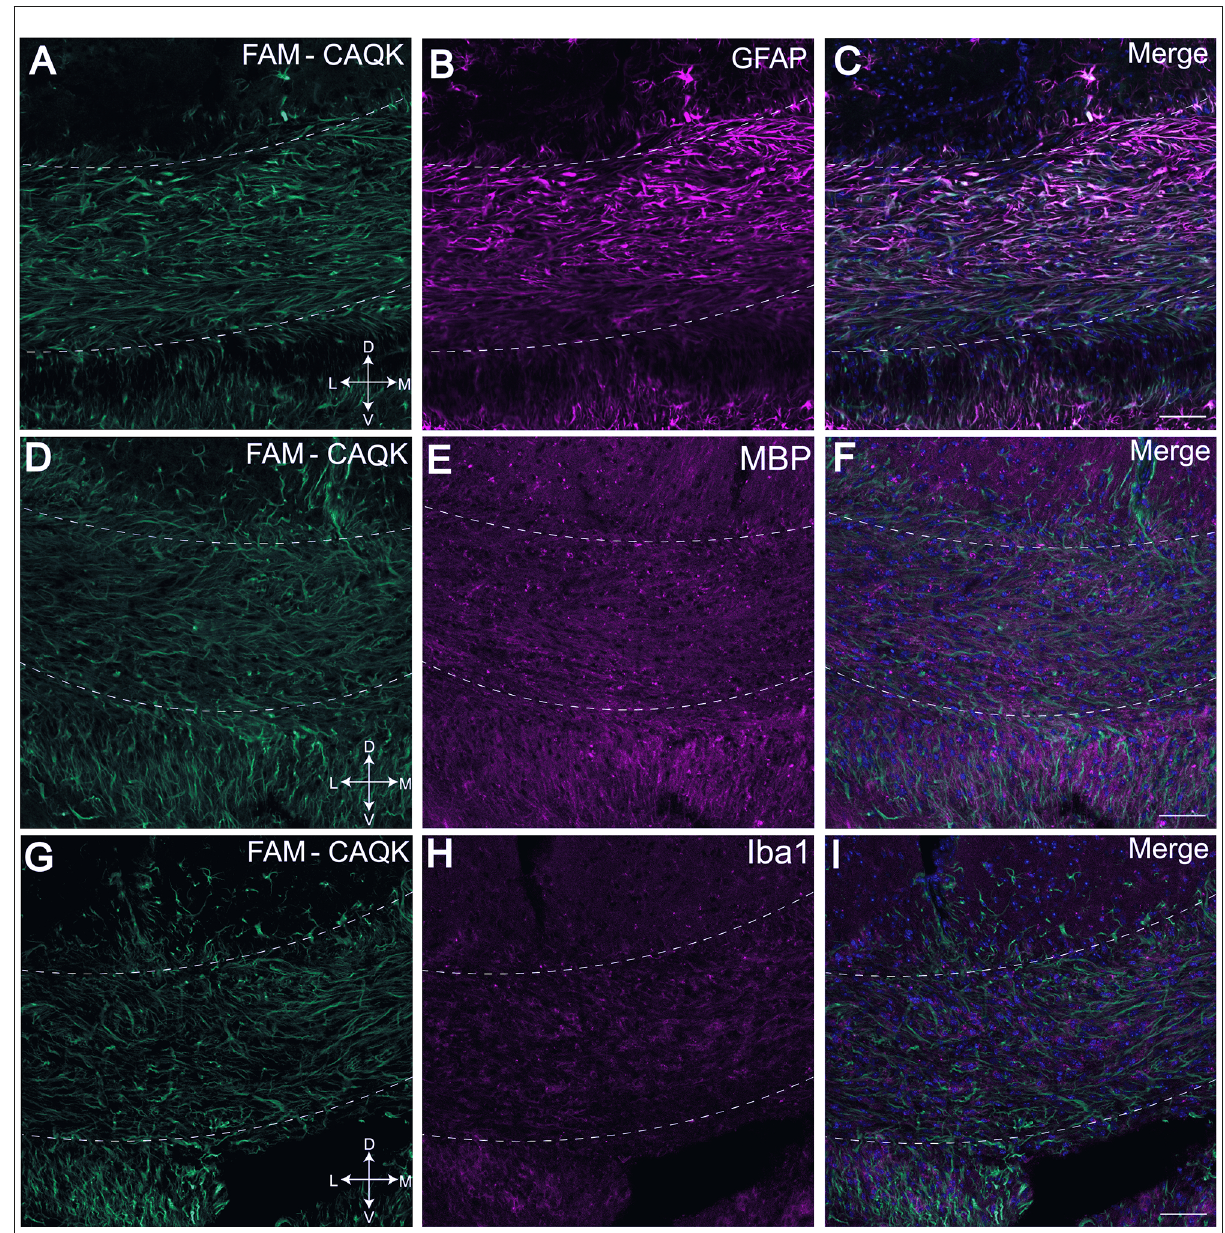
FIGURE3 FAM-CAQK peptide associates with reactive astrocytes in corpus callosum during cuprizone-mediated demyelination. FAM-CAQK peptide is targeted to the demyelinating crossing fiber tracts in the corpus callosum (hatched lines) in mice after 6 weeks on the cuprizone diet ( A,D,G , green). Peptide association (in C ) is prominent with GFAP+ reactive astrocytes ( B , magenta). Staining for MBP+ myelin ( E , magenta) and microglial Iba1 ( H , magenta) is marginal at the 6-week feeding point and no association of FAM-CAQK is evident; merged images (C,F,I) respectively. D, dorsal; V, ventral; L, lateral; M, medial. Scale bar = 50 µ